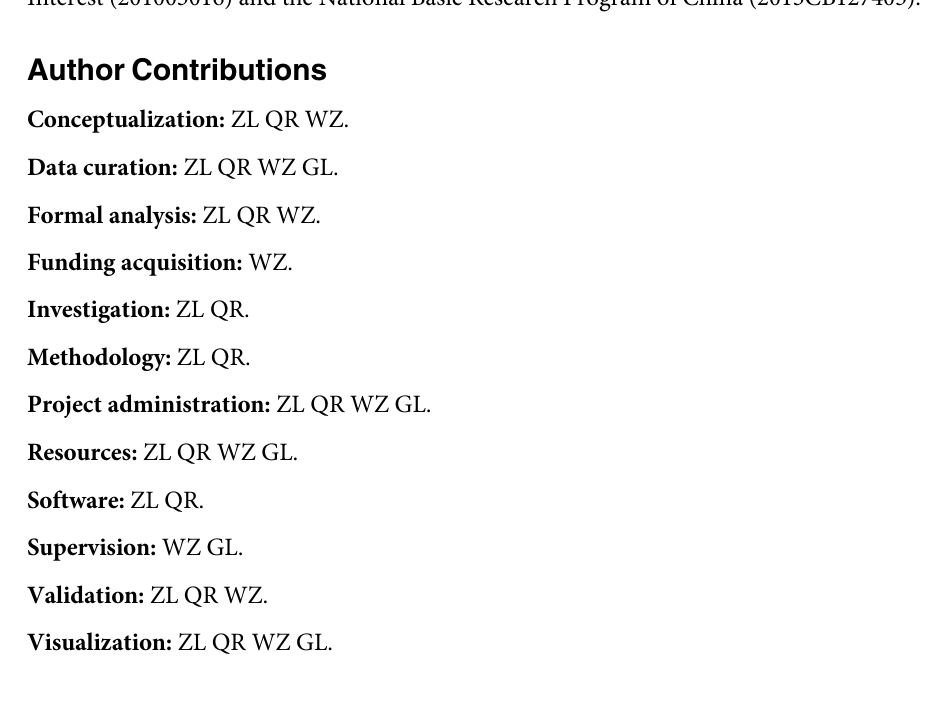
S1 Table. Pearson’s product-moment correlation coefficients among soil biochemical and microbial